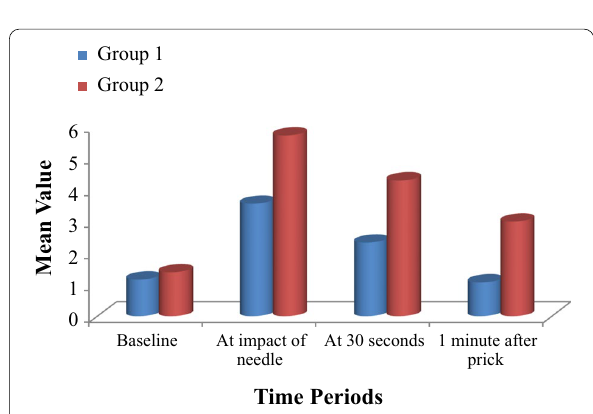
Fig. 2 Comparison of NIPS score between the groups at baseline to subsequent time periods